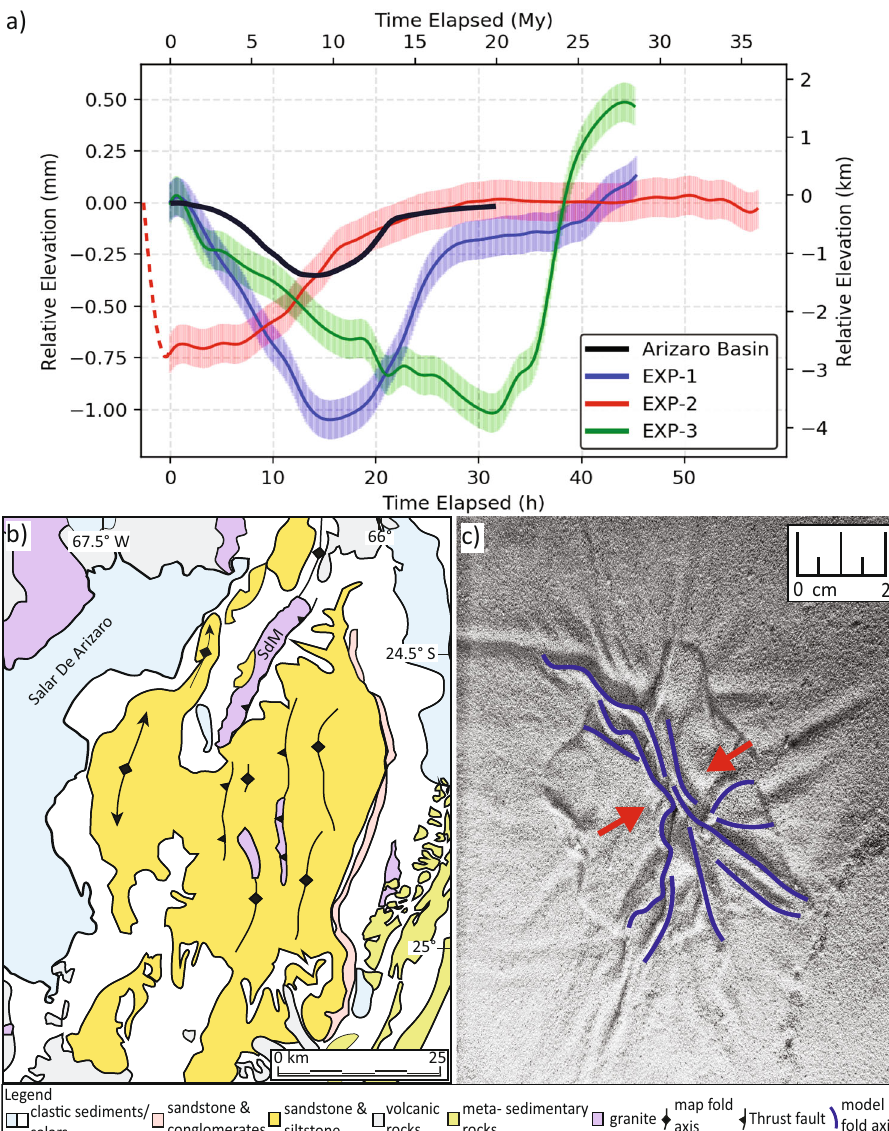
Fig. 5 Comparison of experimental results with the Arizaro Basin. a Relative surface elevation of EXP-1, EXP-2, and EXP-3, with elevation of Arizaro Basin from ref. 33 . The dotted red line in EXP-2 depicts rapid subsidence before the recording began. This occurred in a short span of time between setting up the experiment and starting the camera recording (minutes). b Geological map of the Arizaro Basin, demonstrating folding and thrust faults within the basin, modi fi ed from ref. 33 . Sierra de Macon ridge (SdM). c Surface view of EXP-1 above the drip, demonstrating folding and direction of shortening depicted with red